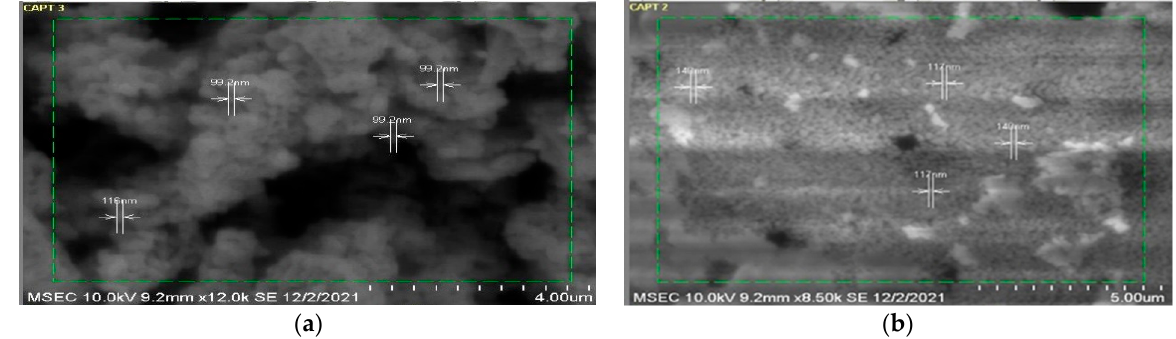
Figure 4. ( a ) SEM image of zinc oxide particles; ( b ) SEM image of iron oxide particles.